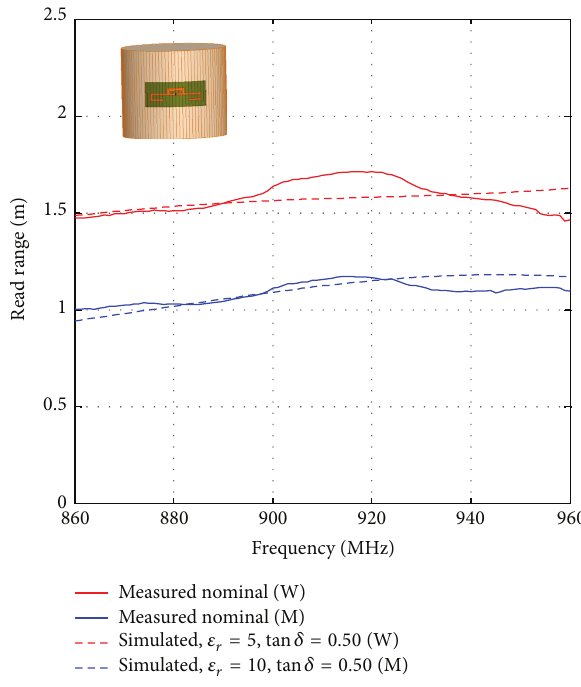
Figure 13: Measured and simulated reference tag on human head and human head model, respectively.